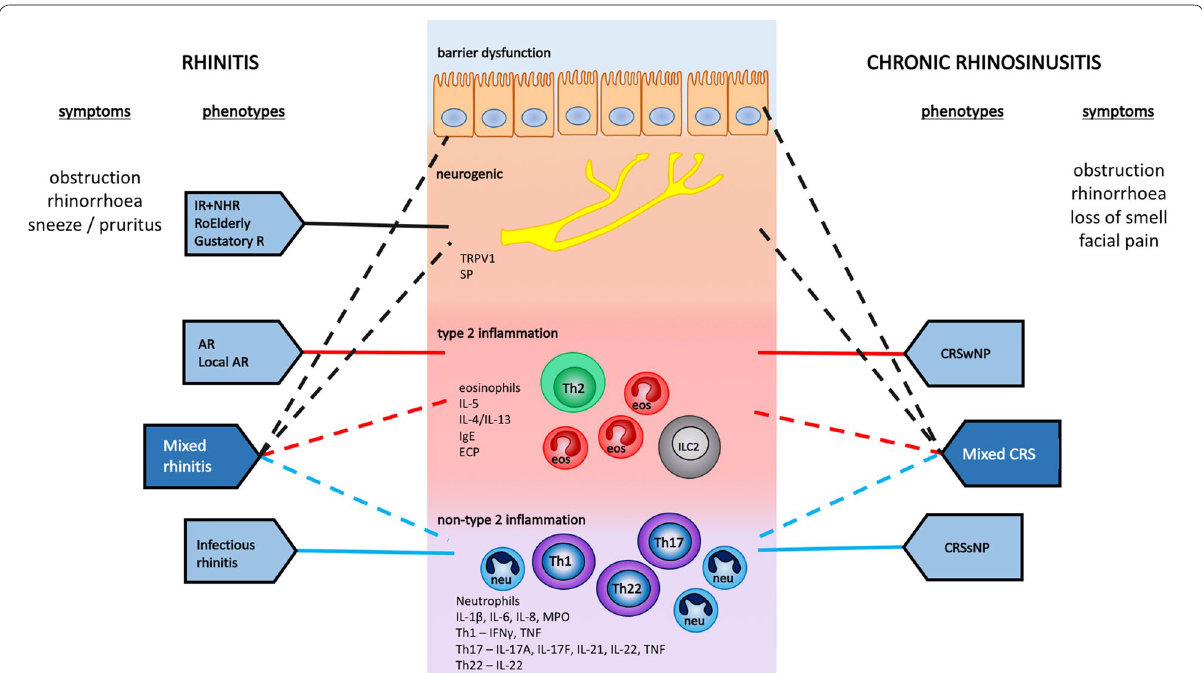
Fig. 1 Overview of endotypes and phenotypes in rhinitis and chronic rhinosinusitis. Endotype predominantly underlying the phenotype, solid lines ; endotype potentially contributing to the phenotype, dashed lines . AR allergic rhinitis; CRSsNP chronic rhinosinusitis without nasal polyps; CRSwNP chronic rhinosinusitis with nasal polyps; IR idiopathic rhinitis; RoElderly rhinitis of the elderly; Gustatory R gustatory rhinitis